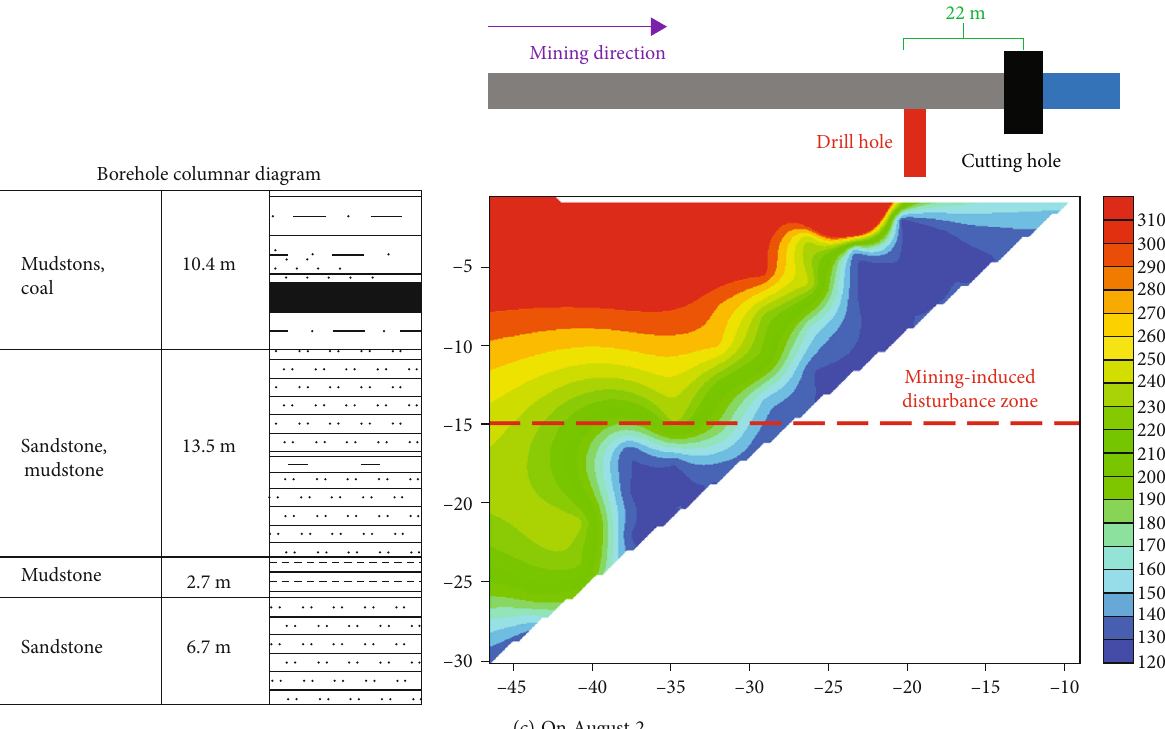
Figure 2: Apparent resistivity of